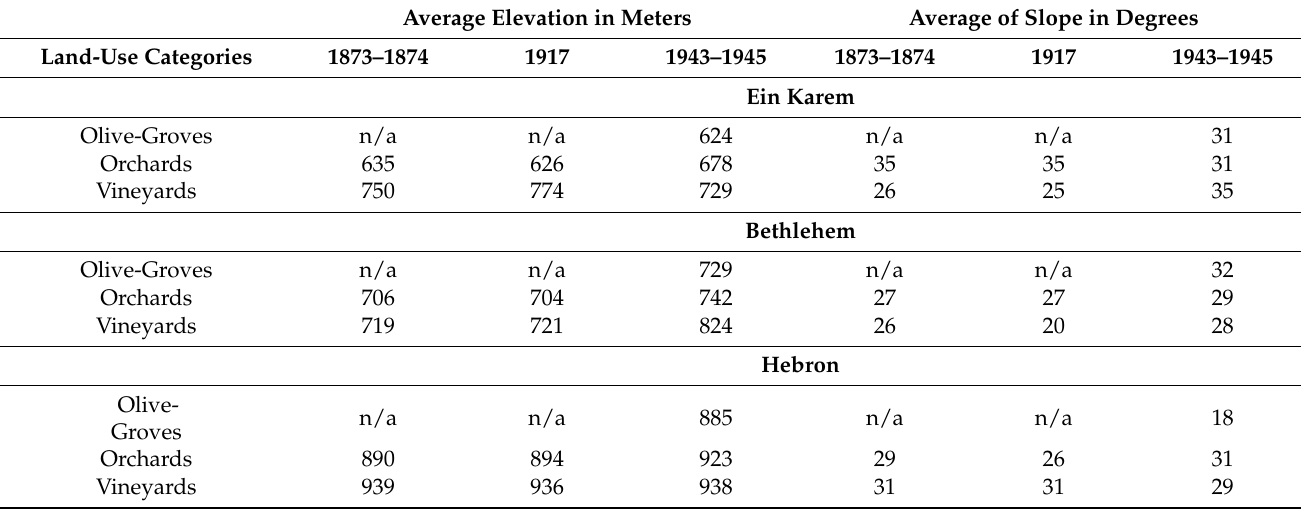
Table 4. The correlation between land-cover categories to elevation and slopes for each period